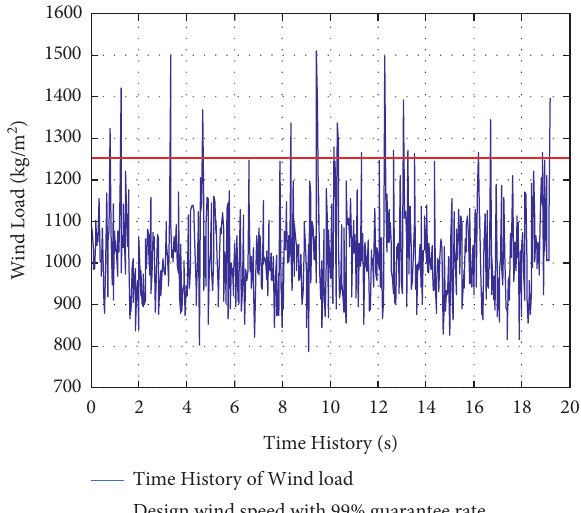
Figure 7: Most of time history are positive, or all of them are